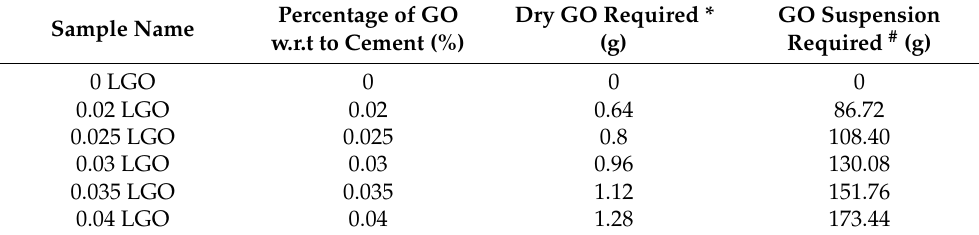
Table 2. Weight of GO in different cement mortar samples used for